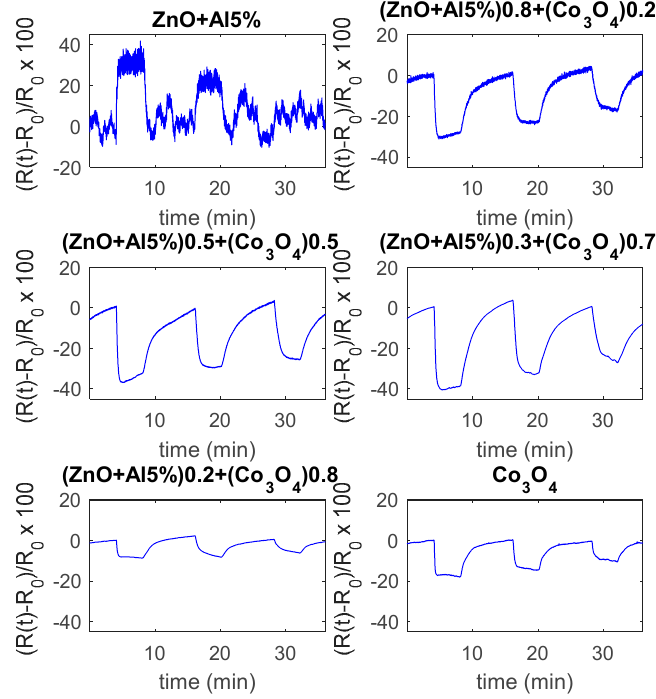
Figure 11. Response to variable NO 2 concentrations as a function of time, at room temperature (RT), for the tested materials. The measurements are performed changing the test mixture composition in the following way: 4 min dry air, 4 min dry air and NO 2 (50 ppm), 8 min dry air, 4 min dry air and NO 2 (25 ppm), 8 min dry air, 4 min dry air and NO 2 (12.5 ppm), 4 min dry air.